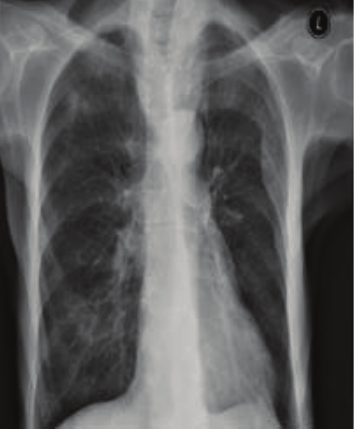
Figure 3: Repeat chest radiograph performed three months later showing a significant reduction in size and number of lung